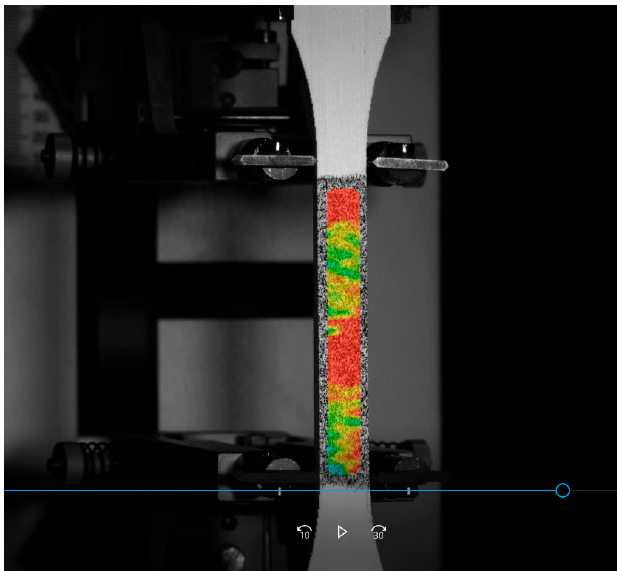
Figure 10. DIC strain distribution of a sample.